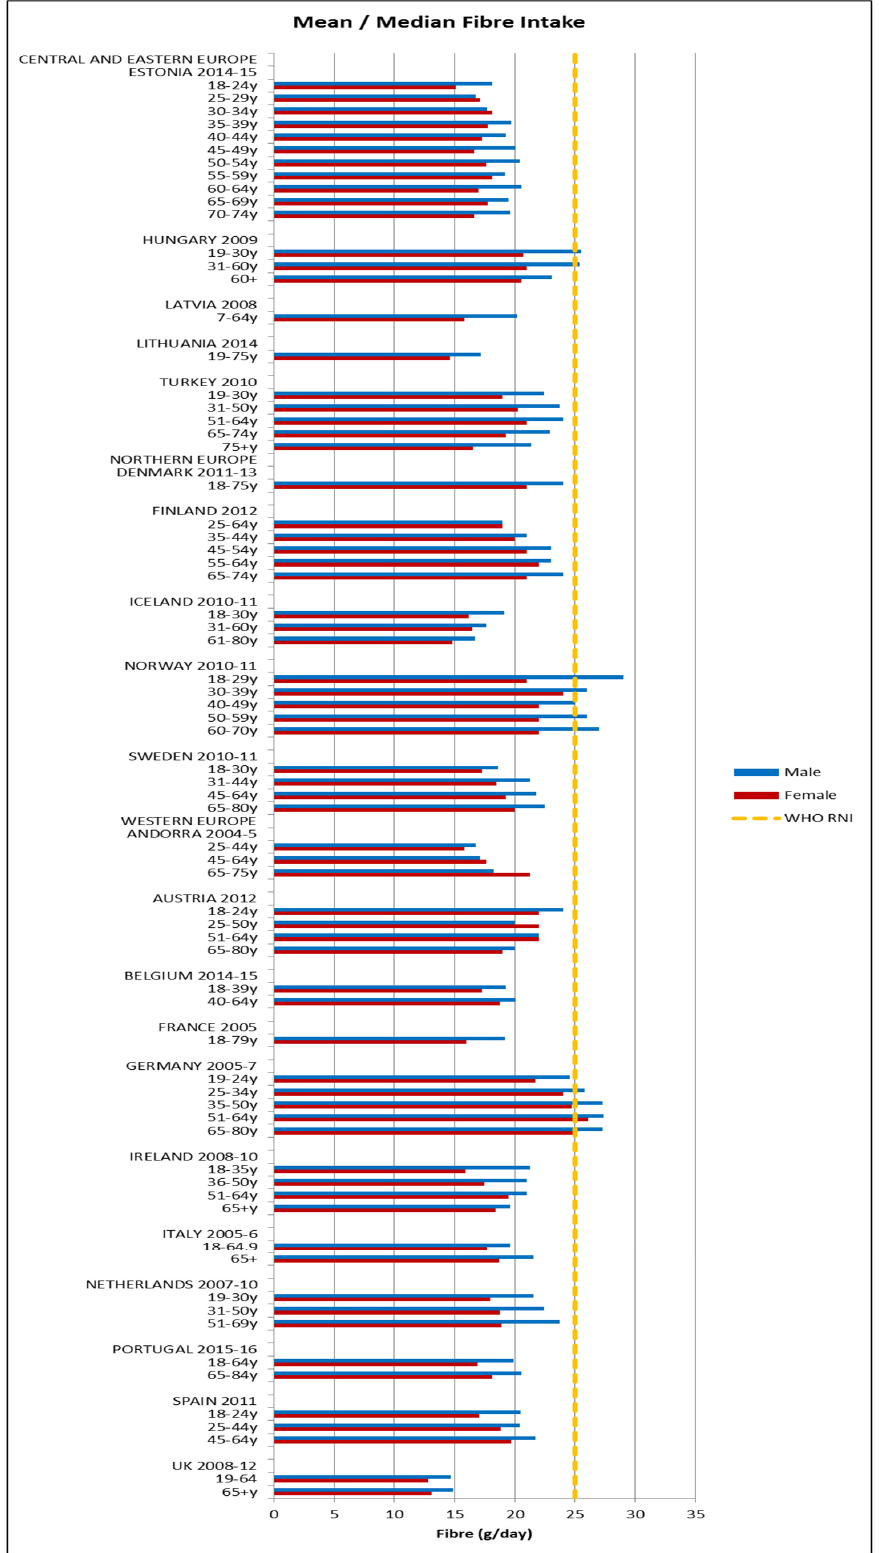
Figure 5. Mean/median* adult fibre intake (g/day) (excluding supplements). * Figures for Spain are based on median rather than mean values.